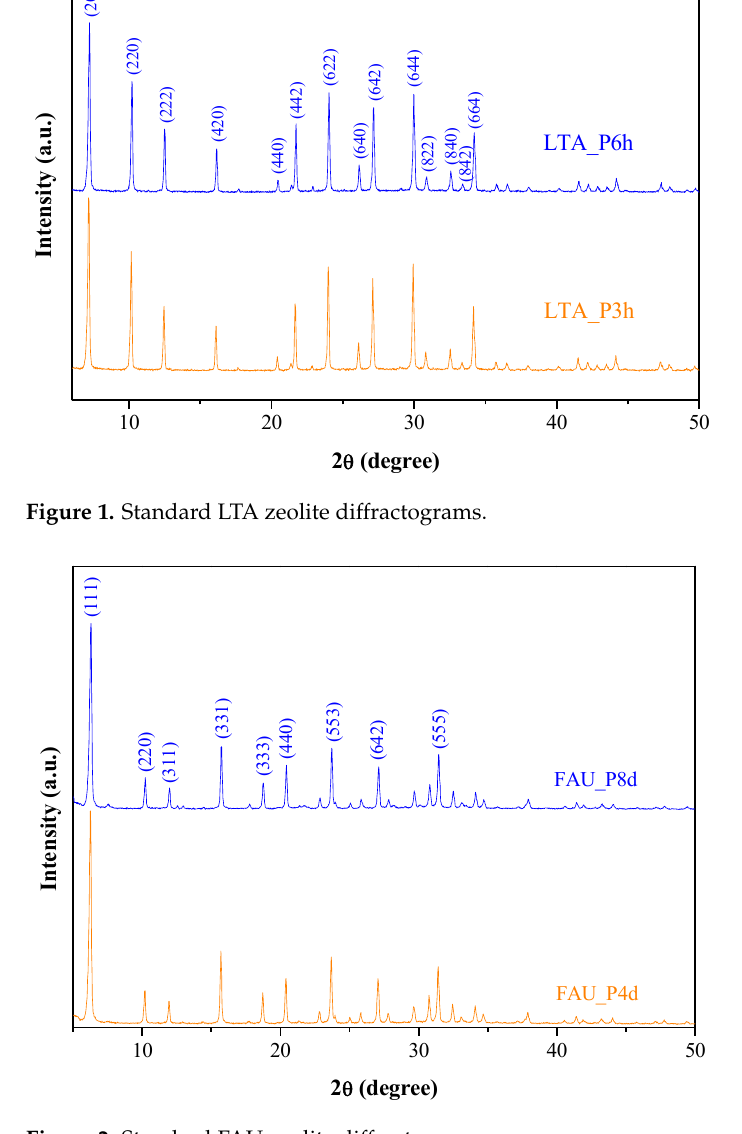
Figure 2. Standard FAU zeolite diffractograms.